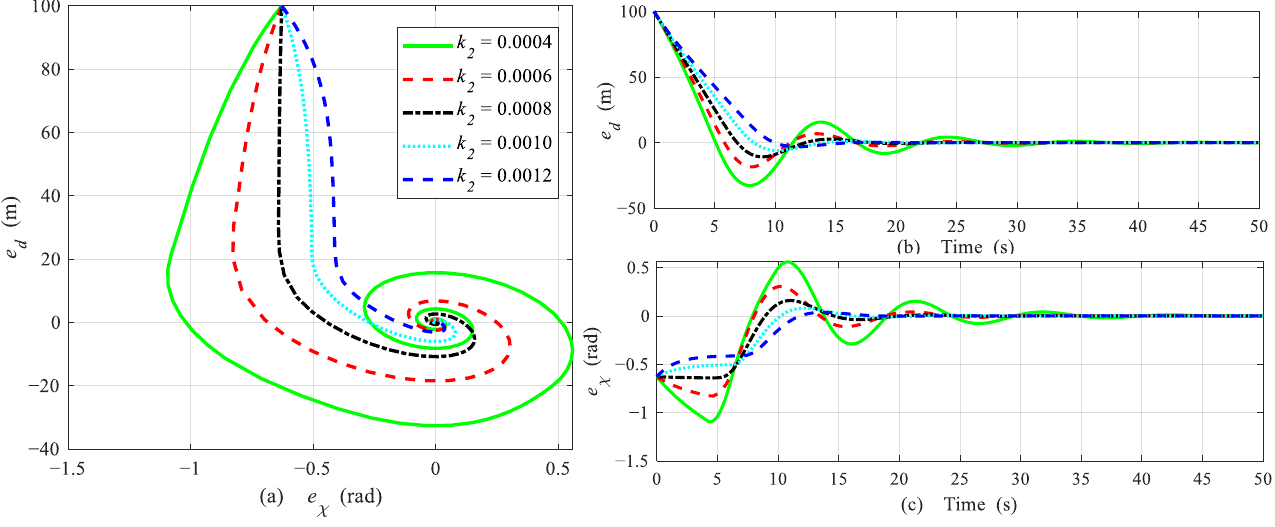
Figure 4. The dynamics of the nonlinear system (9) with ‖∇𝑓‖ = 1 , 𝑉 = 25⁡m/s , and 𝑘 1 = 0.00025 , but under five different values of 𝑘 2 . ( a ) The phase plots of the system (9); ( b ) the trajectories of 𝑒 𝑑 with respect to time; ( c ) the trajectories of 𝑒 𝜒 with respect to time.